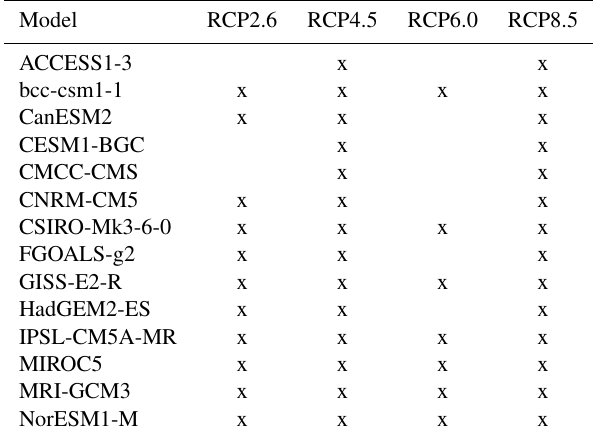
Table 1. List of models and availability under each emission sce-